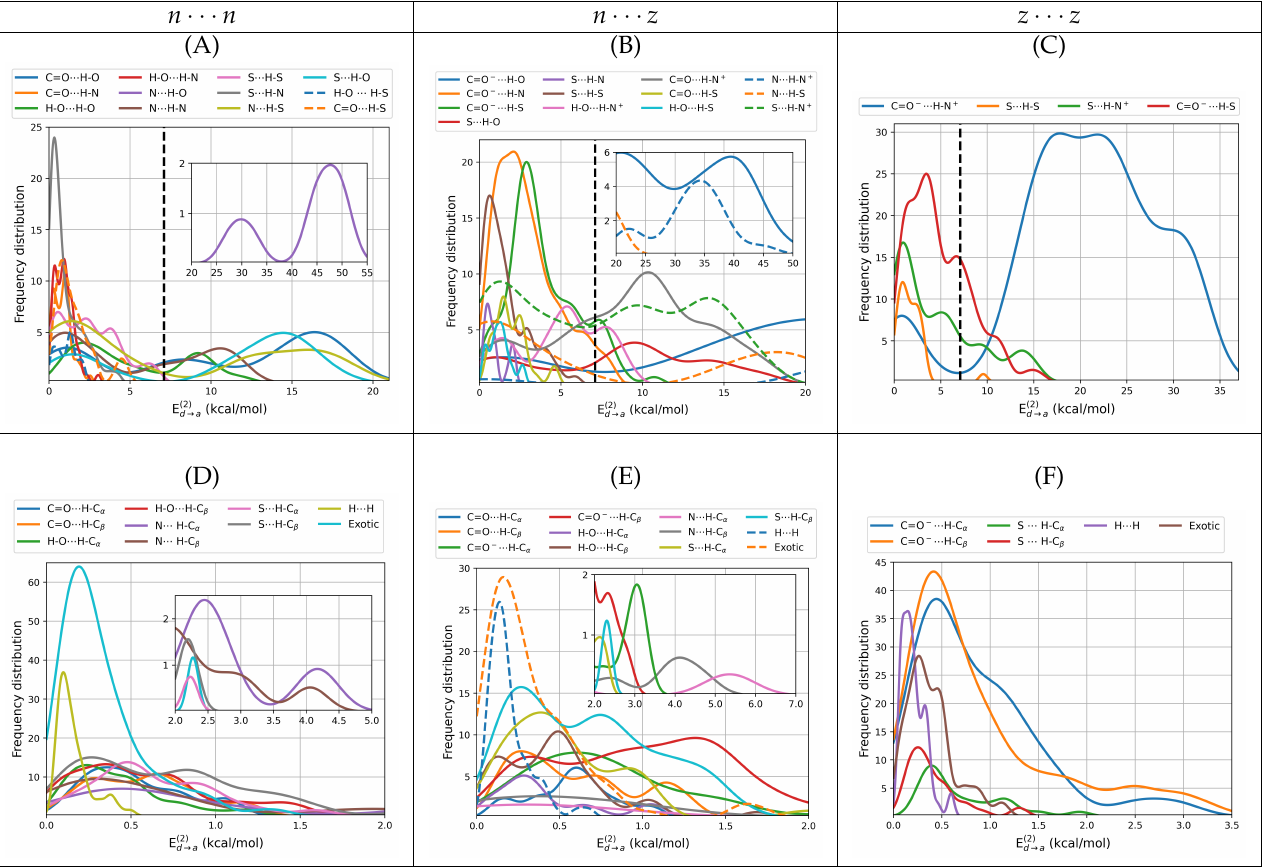
Figure 8. Donor · · · acceptor NBO energies for intermolecular contacts for all dimers of cysteine found in this work. The top row shows only primary hydrogen bonds including salt bridges. The bottom row shows secondary hydrogen bonds, dihydrogen bonds, and all exotic interactions. The left column is reserved for the n · · · n dimers (subfigures ( A , D )), the middle column for n · · · z (subfigures ( B , E )) and the right column for z · · · z (subfigures ( C , F )). All values taken from the B3LYP–D3/6– 311++G( d , p ) potential energy surfaces with water represented as a continuum solvent. The dashed vertical lines mark the reference value for the gas phase water